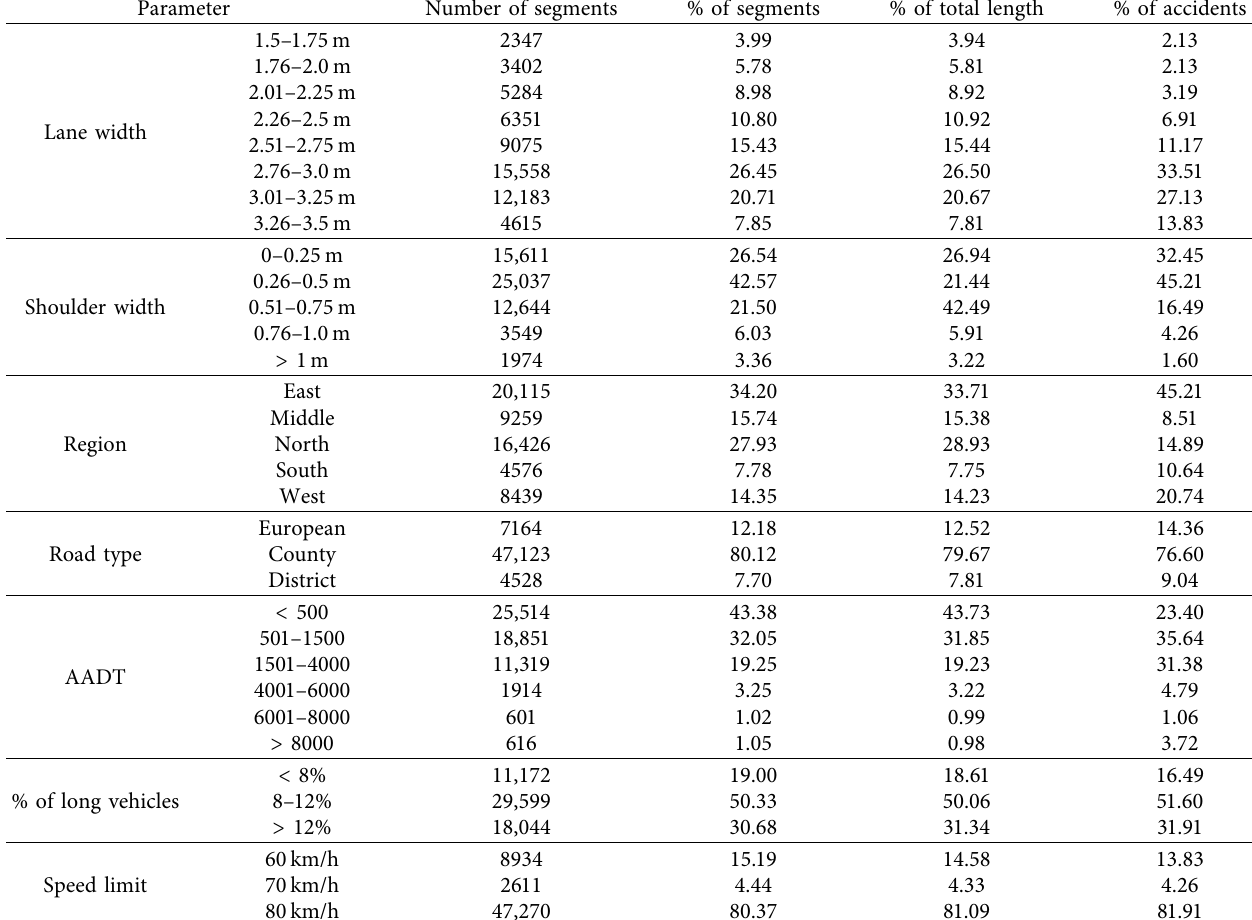
Table 1: Descriptive statistics of the final dataset, 58 815 segments.